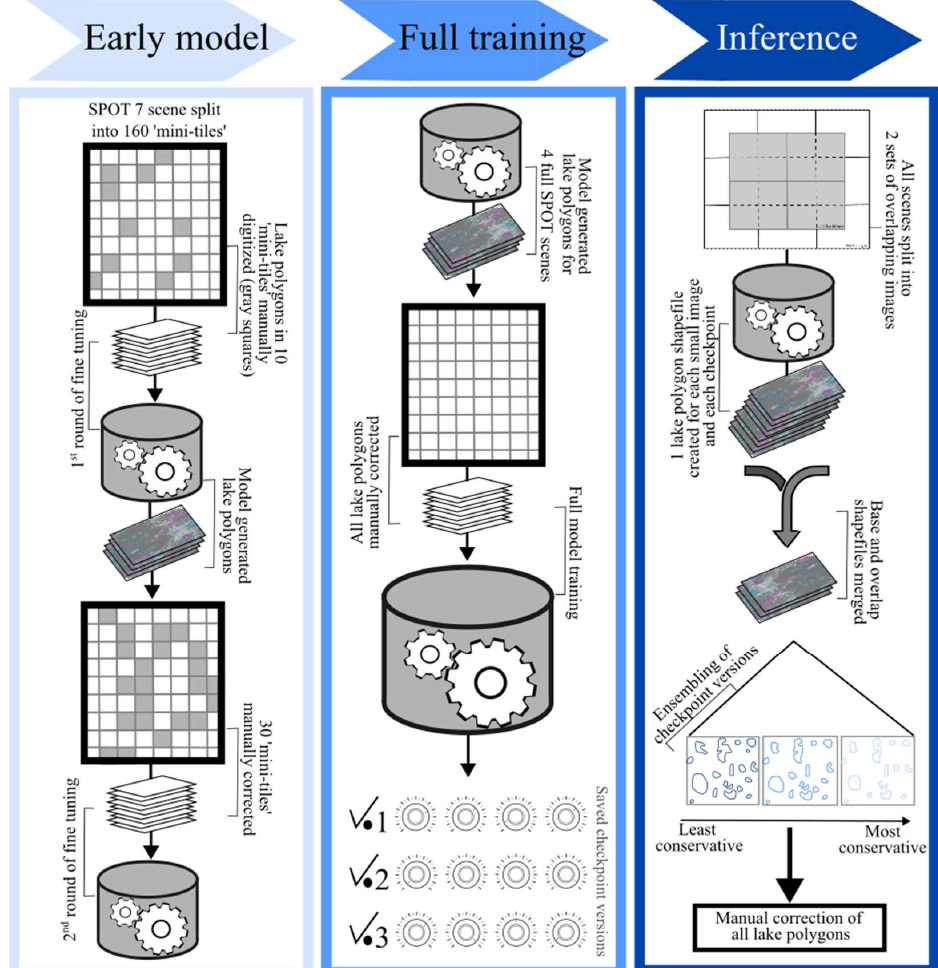
Figure 6. Model development workflow. In the ‘Early model’ panel, the existing PyTorch model is fine tuned twice using a subset of satellite images and manually digitized lake polygons. In the ‘Full training’ panel, the fine tuned model is used to generate lake polygons for four satellite images. All lake polygons associated with each of the four satellite images are manually corrected and used as input for a full training of the model. Three of the 50 checkpoints of the model are saved as version 1, version 2, and version 3. The dials to the right of each ✓ .n represent the different neural network parameters of each version. The ‘Inference’ panel describes the process of using the model to generate lake polygons for all of the satellite images used in the study. Because the satellite images are so big, they need to be split into smaller images before they can be used as input to the model. The satellite images are split twice into base and overlap images to reduce unwanted artifacts at the edges of the small images. After running the model, one lake polygon shapefile is saved for each of the three versions for every satellite image. The three versions are combined using ensembling. All lake polygons are manually corrected before the final lake area change